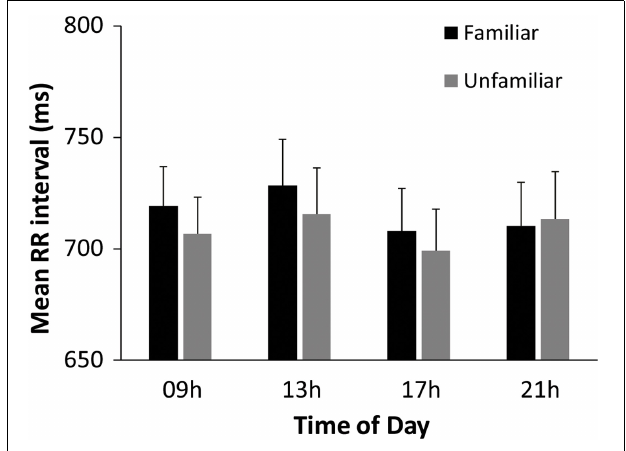
FIGURE 4 | Performer’s mean heartbeat interval (RR interval, in ms) by Time of Day and